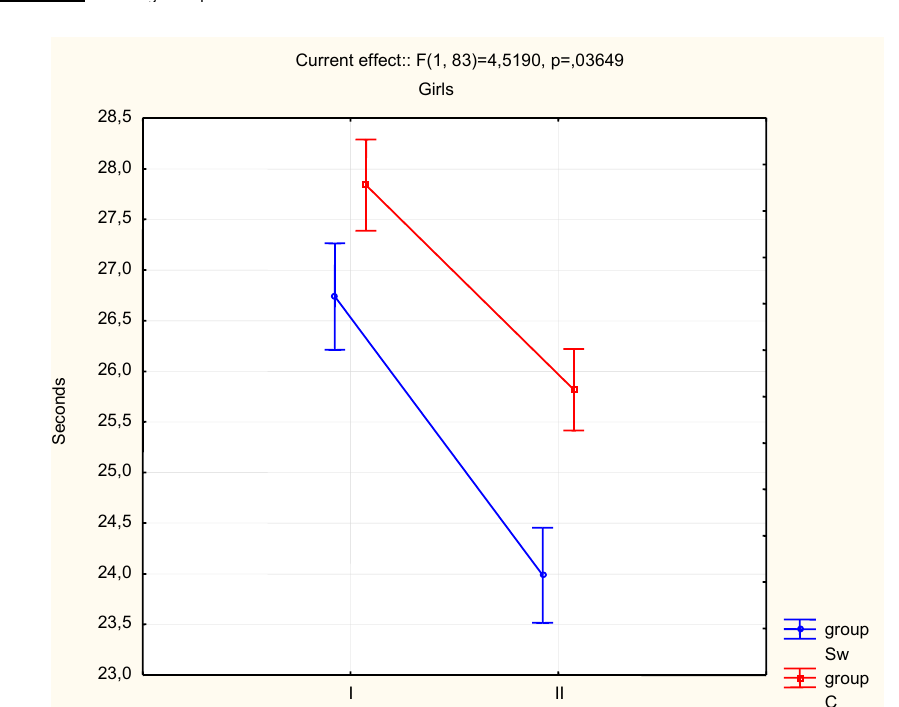
Fig 8. Changes of 10 x 5m Shuttle Run Test (agility run) results in the Swimmers (Sw) group and Control (C) group As for this study, Swimmers group did not attain better dynamics of changes in all tests than the peers from Control group (i.e. speed of upper limb movement, agility, explosive strength, torso strength, agility run). It may be explained by specificity of swimming trainings: it was conducted at swimming pool, not at the gym, where strength of young swimmers could be increased more